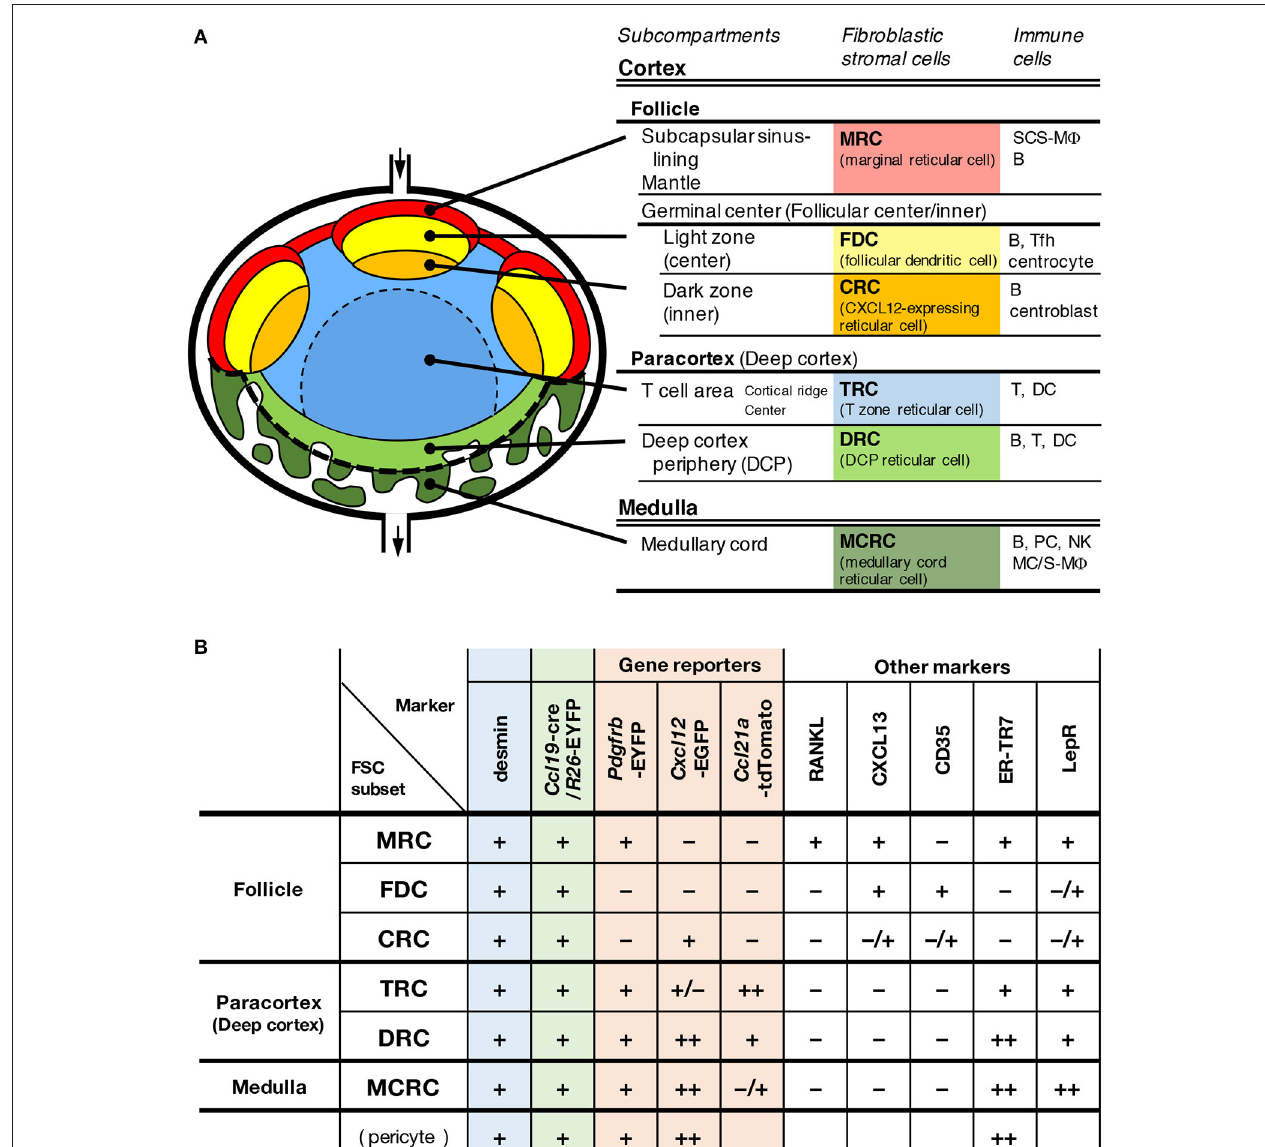
FIGURE 10 | A model of multi-layered subcompartments and associated FSC subsets in mouse LNs. Schematic representation of subcompartmental structures (A) and summary of reporter and marker expression in FSC subsets (B)